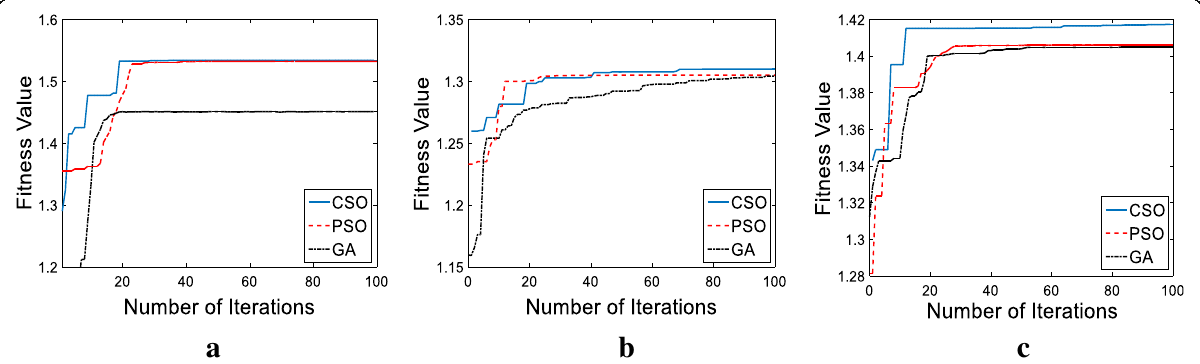
Fig. 2 Performance and the convergence analysis of the different metaheuristic algorithms on different images. a Image 1. b Image 2. c Image